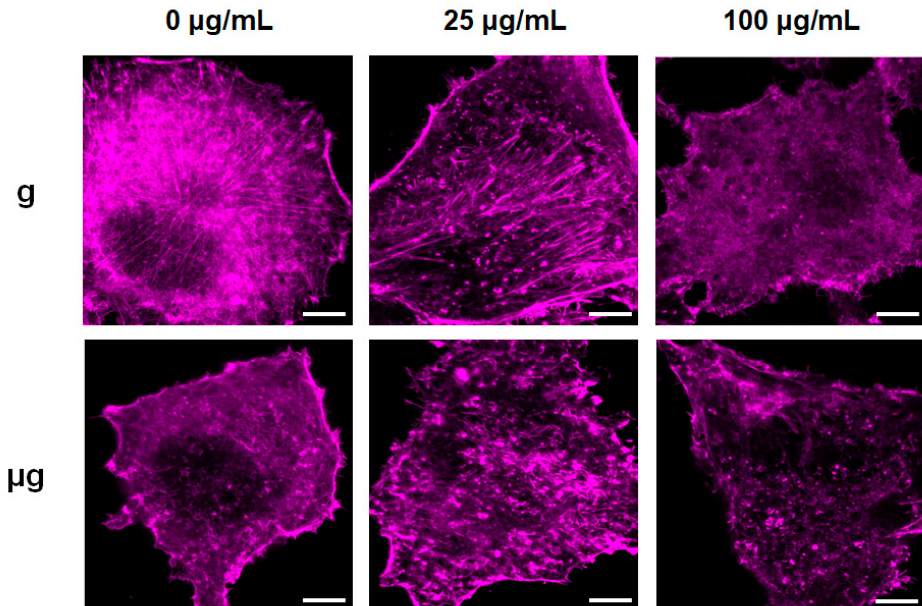
Figure 5. Observation of F-actin distribution by rhodamine phalloidin staining. A549 cells were treated with TiO 2 NPs (0, 25 and 100 μ g/mL) for 48 h under normal gravity (g group) and simulated microgravity ( μ g group), then cells were fixed and stained with Rhodamine Phalloidin, and representative fluorescent images were demonstrated here (pseudo color: purple). Scale bar: 5 μ m.